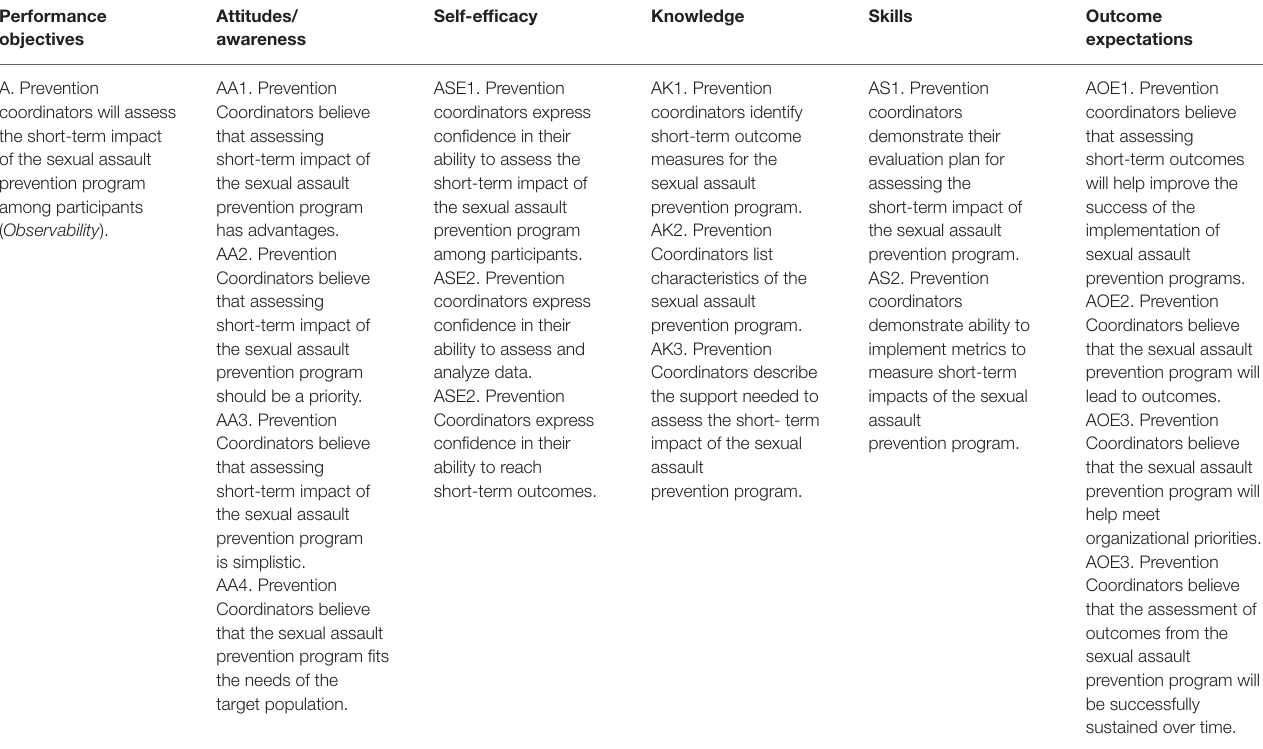
TABLE 3 | Partial matrix of change for observability (subcomponent of motivation).